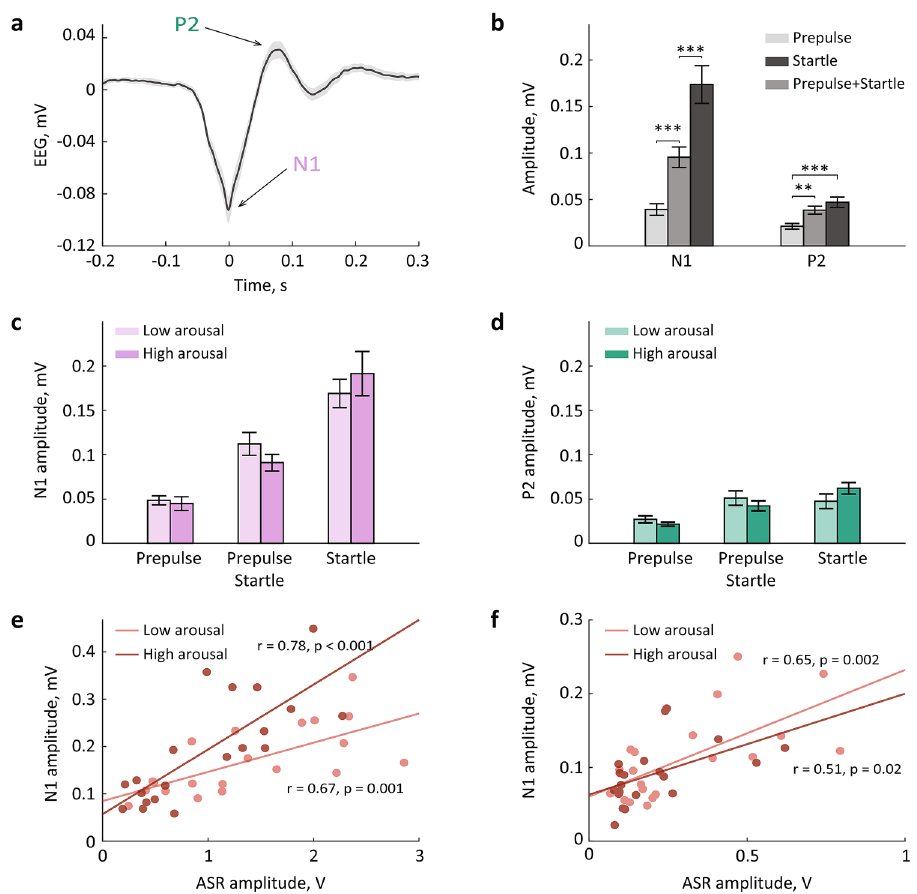
Figure 6. The auditory evoked potential varied across trial types, but not arousal levels. ( a ) A representative AEP trace. The peri-stimulus EEG was averaged over all startle only trials (n = 20 sessions, n = 7 rats); shadow shows s.e.m. Arrows point to the N1 and P2 peaks. ( b ) The N1- and P2-amplitude for different trial types. ( c , d ) The startle-elicited N1 ( c ) and P2 ( d ) amplitudes for low and high arousal trials. ( e , f ) The N1/ASR correlation for startle alone trials ( e ) and the trials with paired tones ( f ). **p < 0.01 and ***p < 0.001 (post hoc comparisons, Bonferroni